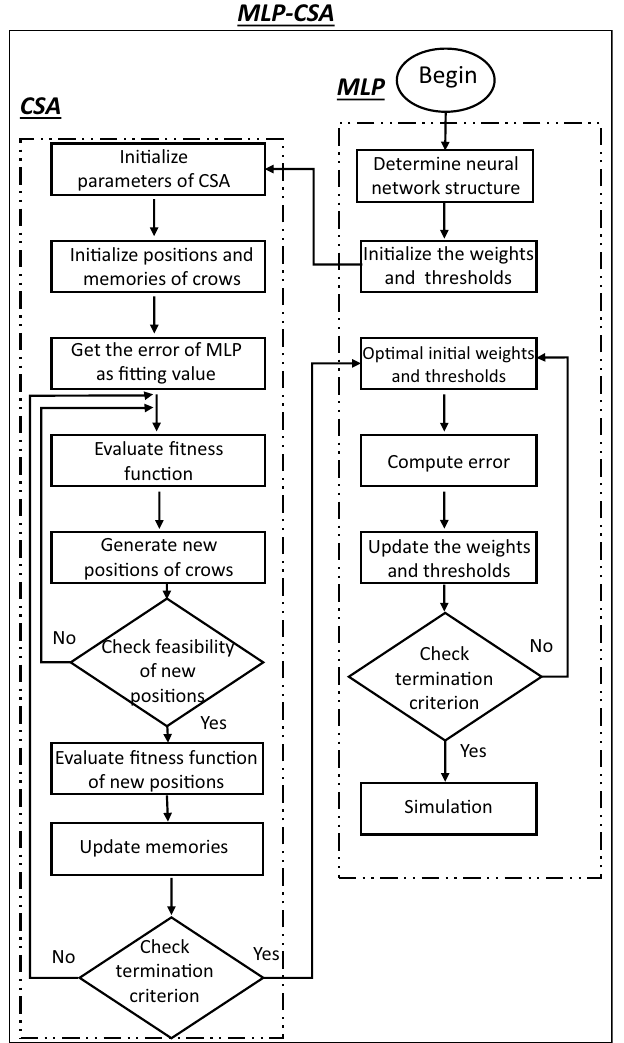
Figure 2. MLP-CSA model for the prediction of functional properties of nano TiO 2 coated